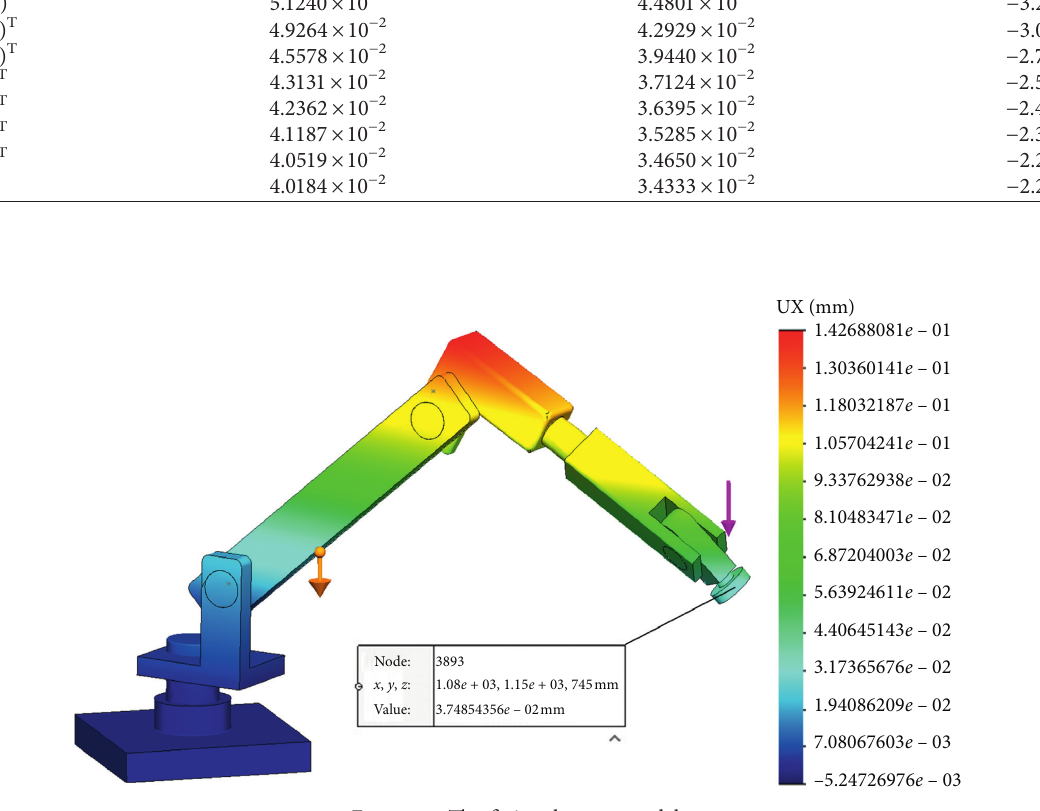
Figure 5: The finite element model. Table 4: The results of parameters